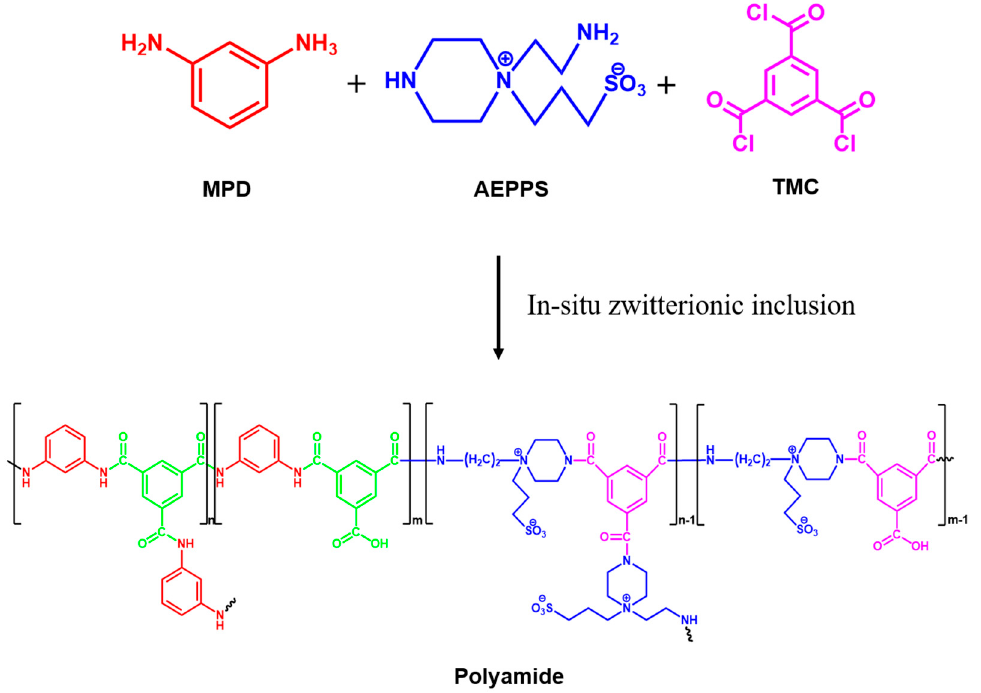
Figure 3. The schematic diagram for in-situ inclusion of zwitterionic moieties in FO membrane (reproduced from Chiao et al. [13]).